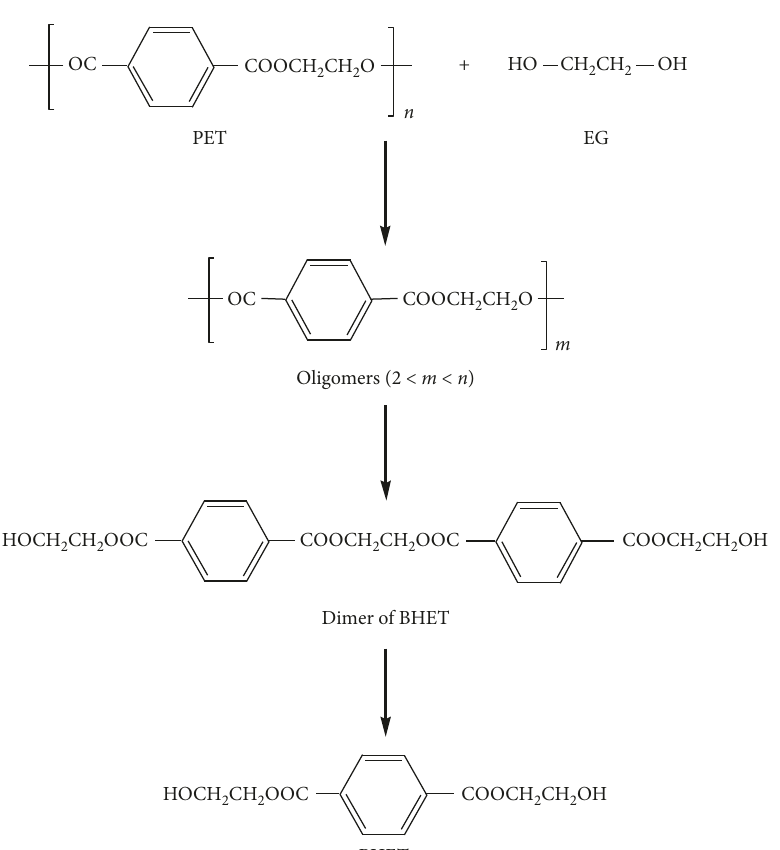
Figure 2: Chemical reaction route for